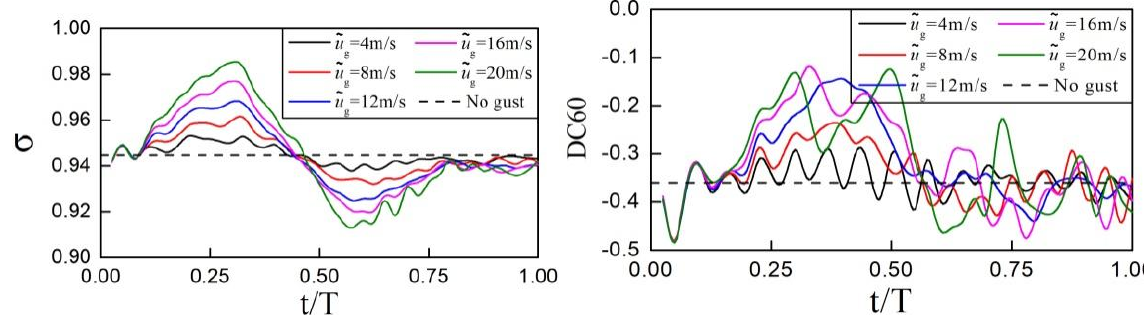
Figure 26. Time histories of the inlet performance responses to the gusts with various amplitudes at a frequency of f = 50 Hz.